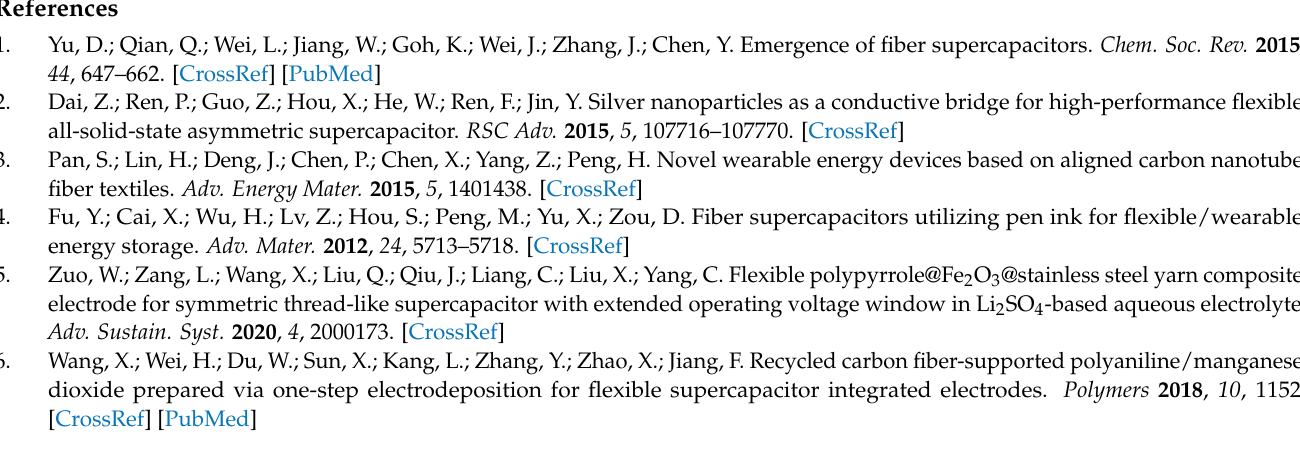
samples; Figure S2. (a) Optical picture of the comparison of the nylon/Ag substrate before and after heat curing; (b) Optical picture of the electrode fabricated via directly electrochemically polymerizing PPy on nylon/Ag; Figure S3. SEM images of the nylon yarn: (a) 40 × magnification; (b) 3000 × magnification; Figure S4. 3D profiles of (a) the nylon/Ag yarn and (b) the nylon/Ag/PPy yarn after chemical polymerization; Figure S5. Variation of IR drop with different discharge currents of nylon/Ag/MnO 2